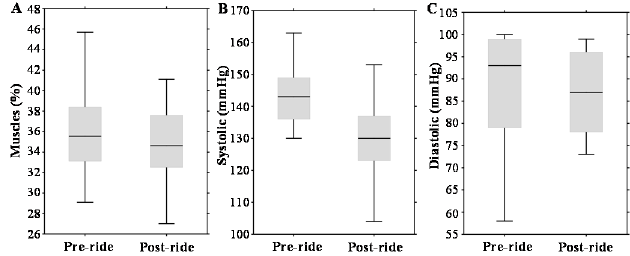
Figure 1. Effect of physical exercise on anthropometric parameters, expressed as box plots for: ( A ) total muscles; ( B ) systolic pressure; and ( C ) diastolic pressure. The middle lines in the figures indicate the median values.